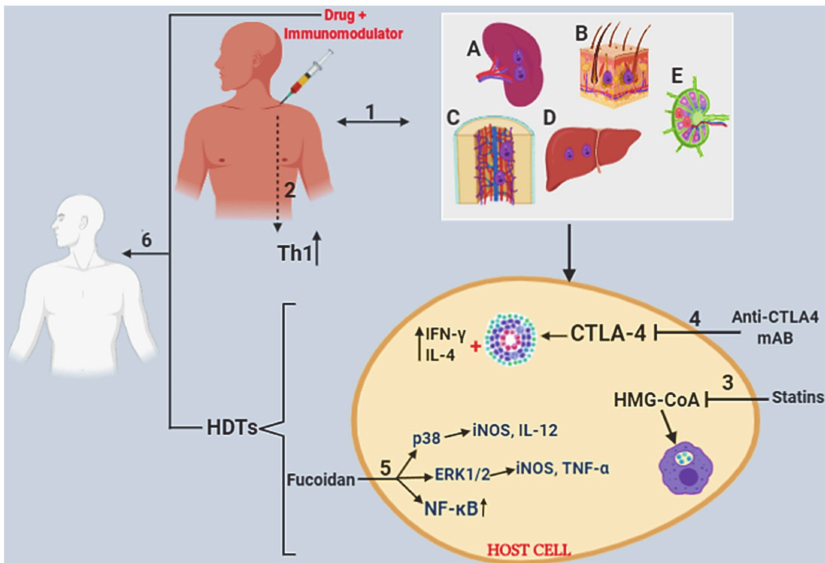
Figure 2. Host-directed therapies and immunochemotherapies and the protective roles they play in the mammalian host. ( 1 ) Various organs ( A , infected spleen; B , infected skin; C , infected bone marrow; D , infected liver; and E , infected lymph node) are infected with Leishmania , the site depending on the infecting spp. ( 2 ) Administration of a drug in combination with an immunomodulator e.g., cytokines, co-stimulatory / inhibitory molecules, immune cells, which increase the antileishmanial Th1 population and boosts subsequent parasite clearance (3–5), represents a host-directed therapeutic drug target. ( 3 ) The administration of statins (an inhibitor of hydroxy-3-methylglutaryl coenzyme A reductase) enhanced host macrophage phagosome and killing e ff ector function by lowering host cholesterol. ( 4 ) Inhibiting the cytotoxic T lymphocyte Ag-4 led to increased granuloma formation and IFN- γ and IL-4 production by the liver and spleen, which induced host-protective immunity. ( 5 ) Fucoidan activated p38 and ERK1 / 2 pathways leading to increased iNOS production, whereby p38 increased IL-12 levels and ERK1 / 2 enhanced TNF- α and NF- κ B signal transduction for host-protective immunity. ( 6 ) Combination of drugs and HDTs leads to parasite clearance. Figure was created in